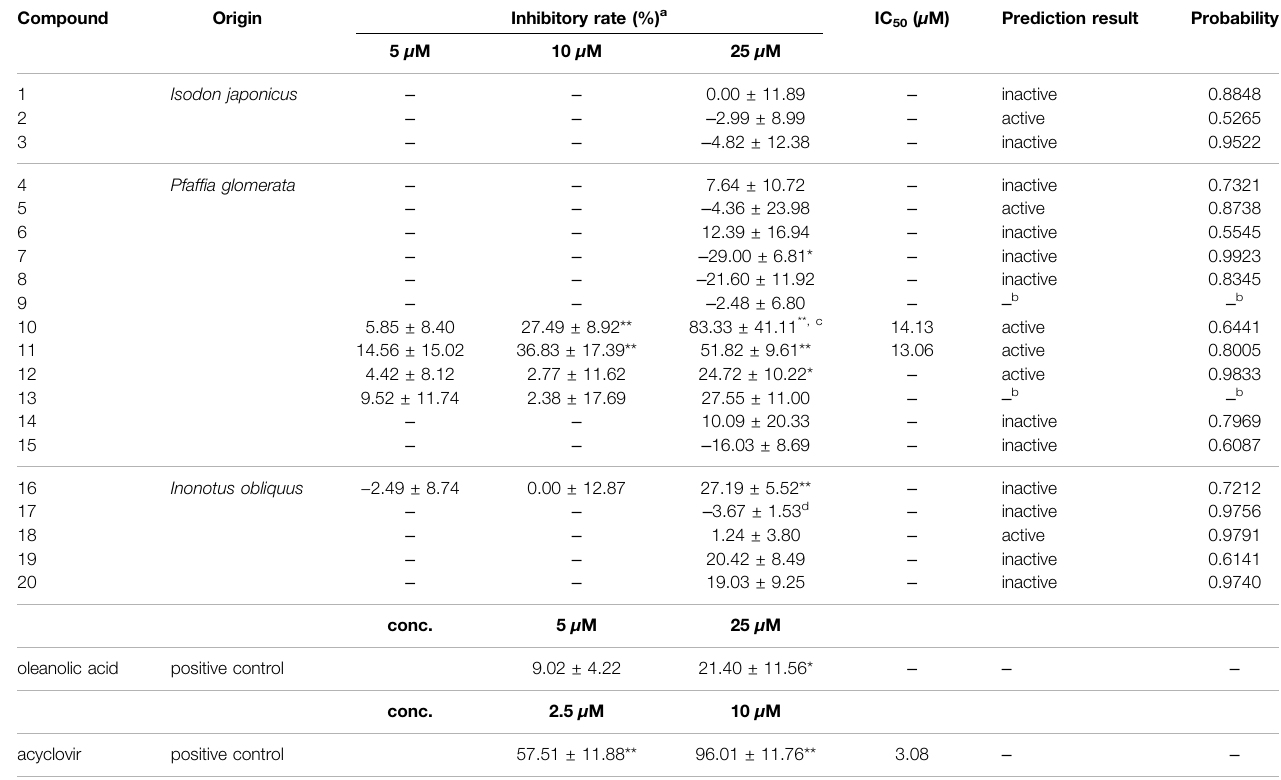
TABLE 4 | Anti-HSV-1 activity of triterpenes.